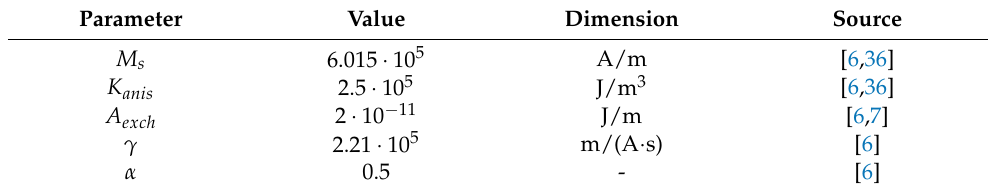
Table 1. Material